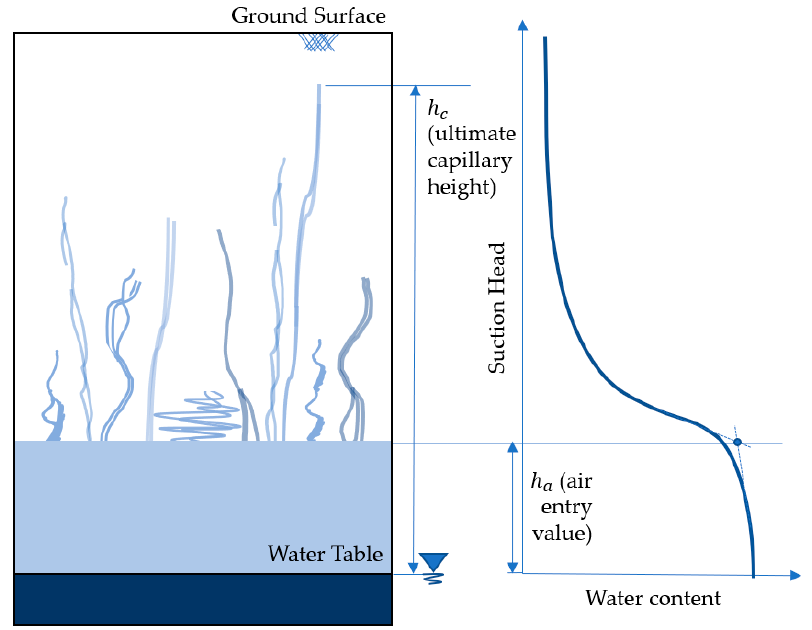
Figure 9. Conceptual model of capillary rise, and the associated water content versus suction head relationship, modified from [11].